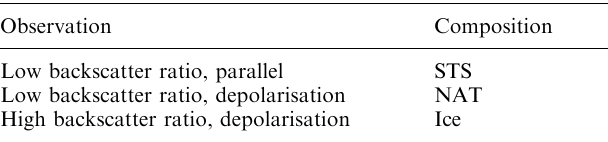
Fig. 8. Observations of PSCs in the winter of 1997–1998